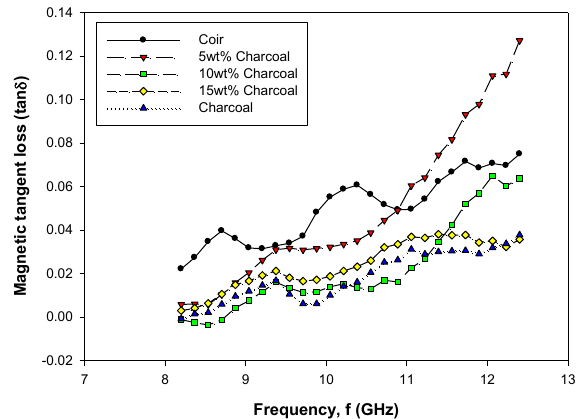
Figure 6: Magnetic tangent loss of 5 samples